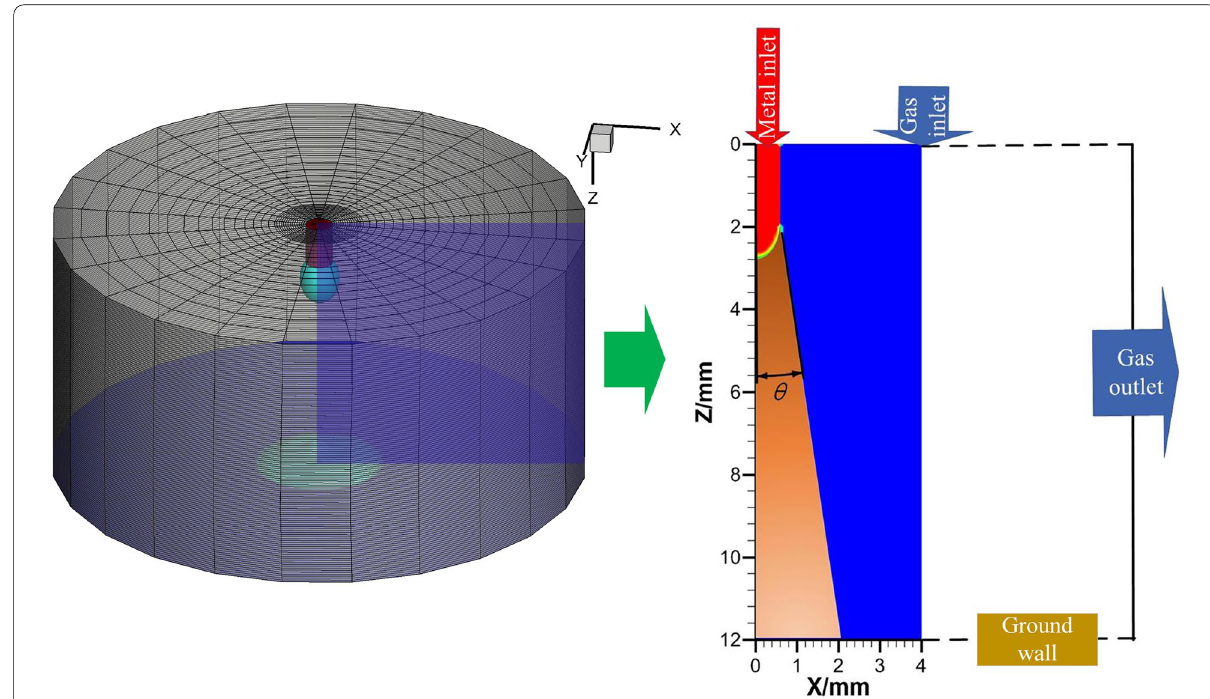
Figure 1 Calculated domain and boundary